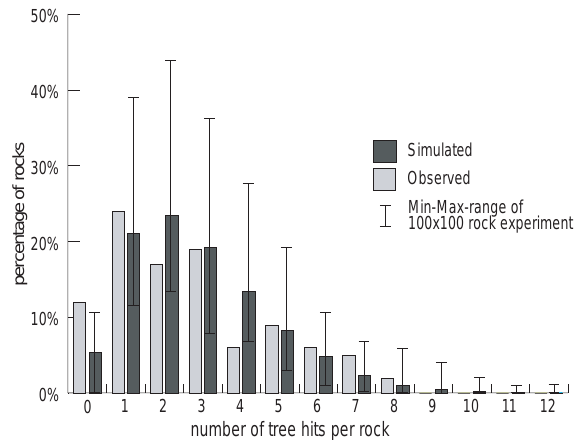
Fig. 8. Observed and simulated frequency of rocks in categories for “number of tree hits per rock” for the forested Site 2 in Vaujany. The simulated tree hits are represented by the mean value of 10000 sim- ulated rocks, the error bars indicate the minimum/maximum range of 100 simulated rocks with 100 replicates